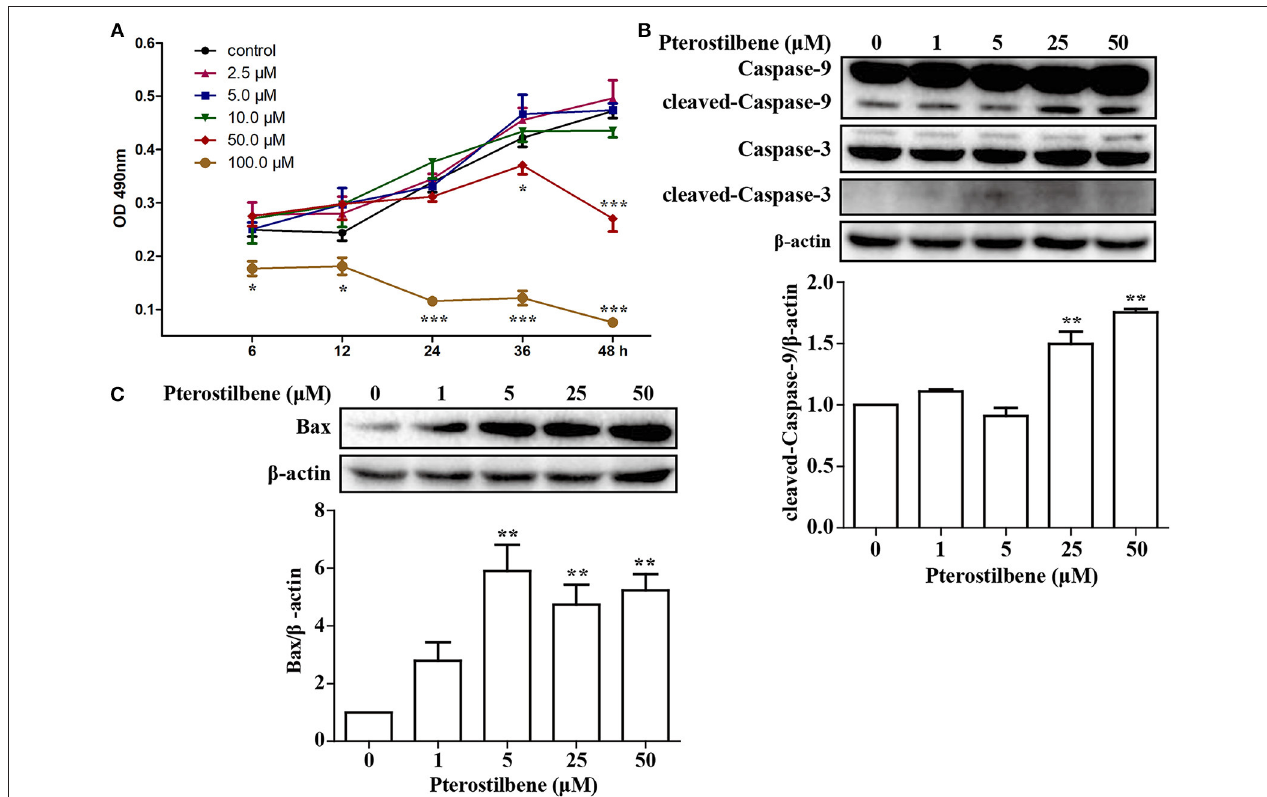
FIGURE 1 | Effect of pterostilbene on the viability of cancer cells: (A) Cell proliferation at different treatment concentrations and time points; (B) Expression of caspase-3 and − 9 as determined by Western blot analysis; (C) Expression of Bax as evaluated by Western blot analysis. Reported values are mean ± SEM. * p < 0.05, ** p < 0.01 and *** p < 0.001, indicate significant differences compared with the control group.